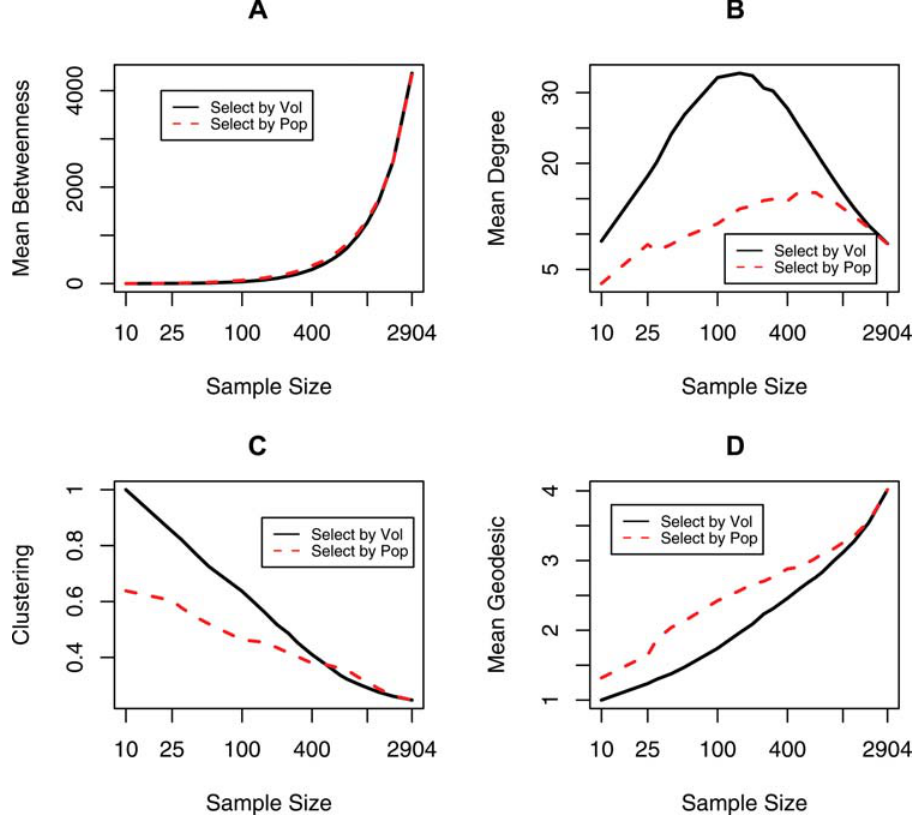
Figure 3 a–d. The relationships between network characteristics and sizes of network samples. Samples are selected based on flight volume (solid black line) and population (broken red line). Subplots correspond to the following network characteristics: (a) betweenness, (b) degree, (c) clustering, and (d) geodesic.